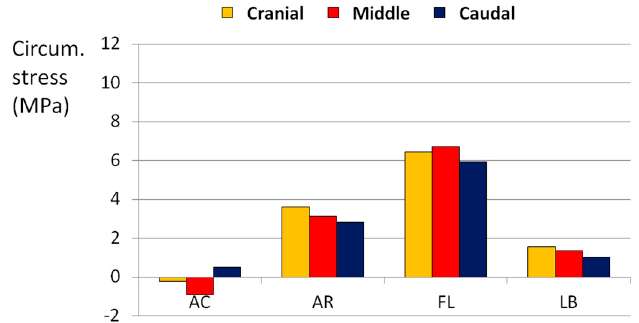
Figure 10. Circumferential (Circum.) stress generated in the POST section by pure loads. AC means axial compression, FL means flexion, AR means axial torsionrotation, LB means lateral bending.